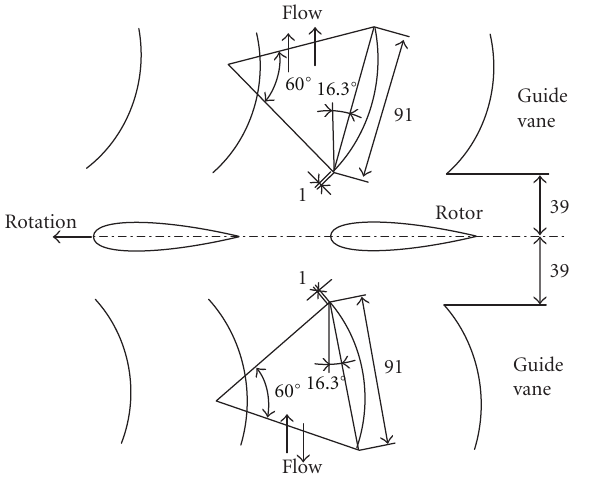
Figure 4: Wells turbine with guide vanes (WTGV).